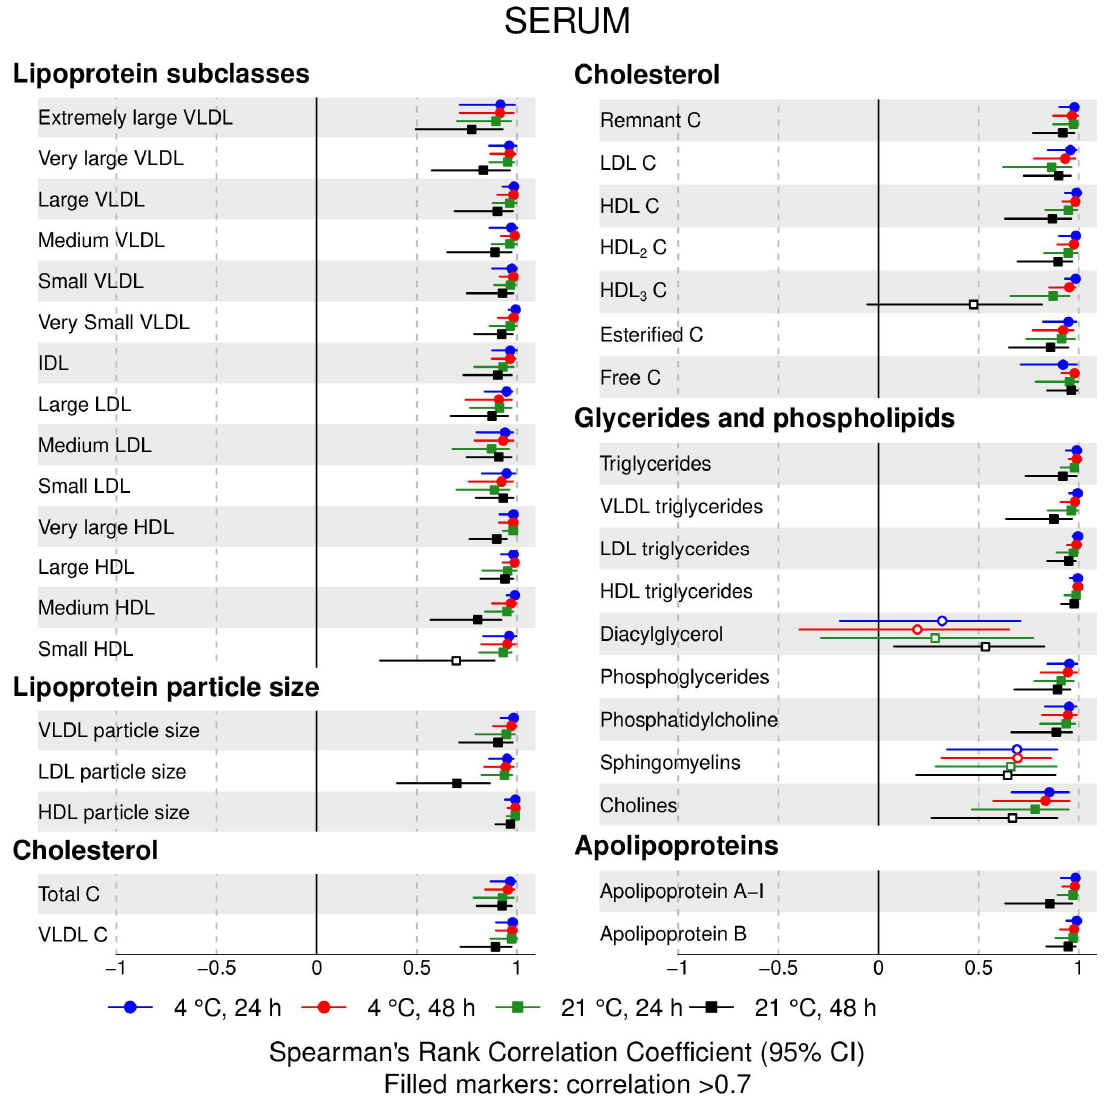
Figure 1. Serum, pre-storage handling effects: Spearman’s rank correlation coefficients between metabolic trait concentration/value in reference samples (4 °C, 1.5 h) and samples incubated at (i) 4 °C, 24 h; (ii) 4 °C, 48 h; (iii) 21 °C, 24 h; and (iv) 21 °C, 48 h, before centrifugation (correlations for lipoprotein trait details are given in Figure S1, Supplementary Materials). Spearman’s rank correlation coefficients and 95% confidence intervals (CIs) are listed in Table S2, Supplementary Materials. C, cholesterol; IDL, intermediate-density lipoprotein; LDL, low-density lipoprotein; HDL, high-density lipoprotein; VLDL, very low-density lipoprotein.